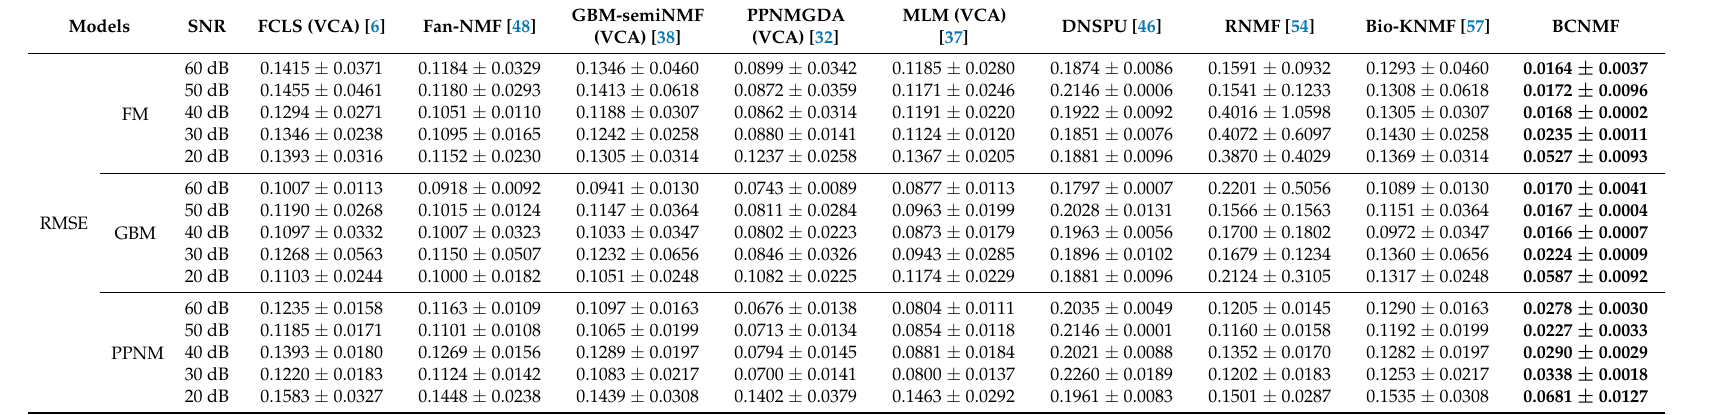
Table 7. RMSEs of all algorithms with different